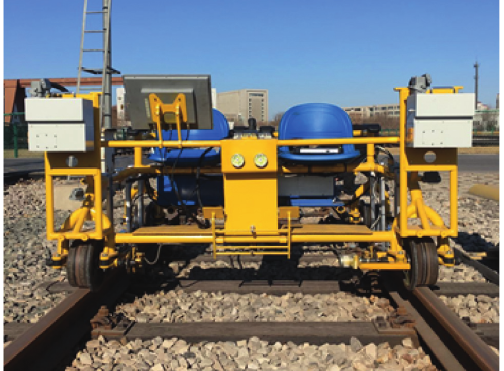
Figure 6: Data acquisition equipment.